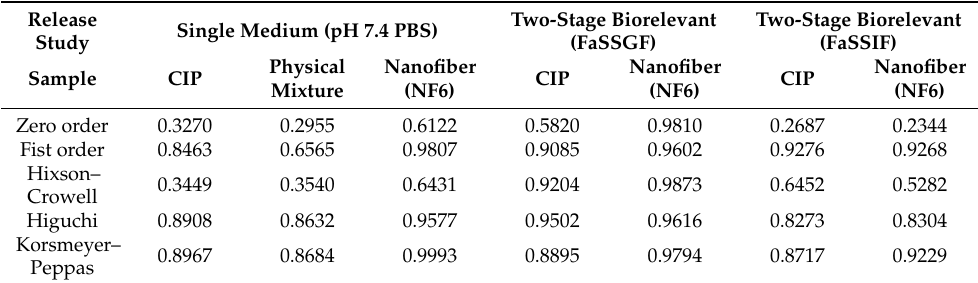
Table 6. Regression coefficient values of the different drug release models. Release Single Medium (pH 7.4 Study